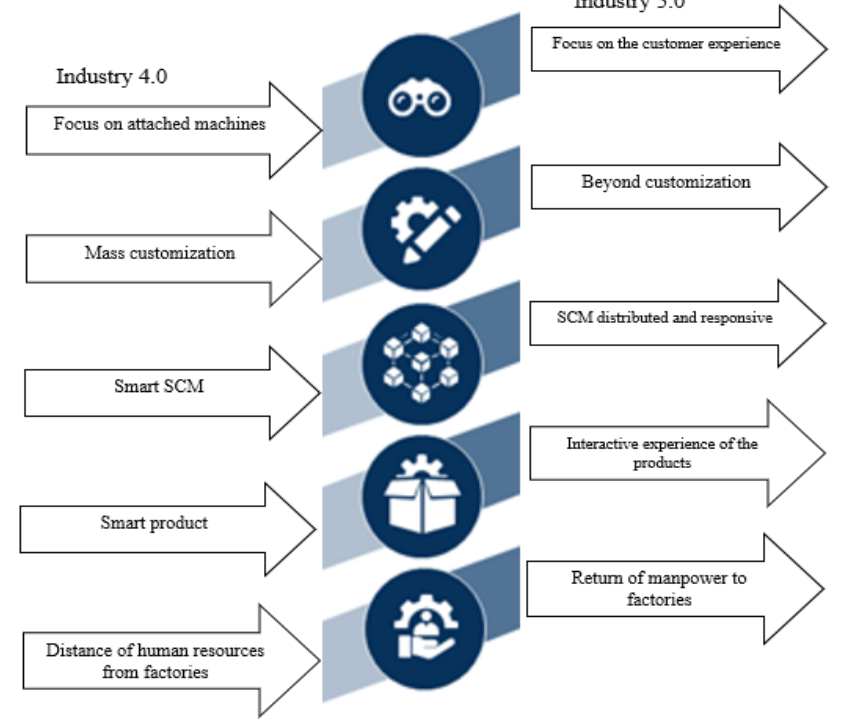
Figure 1. Comparison of concepts in Industry 4.0 to 5.0 [34].